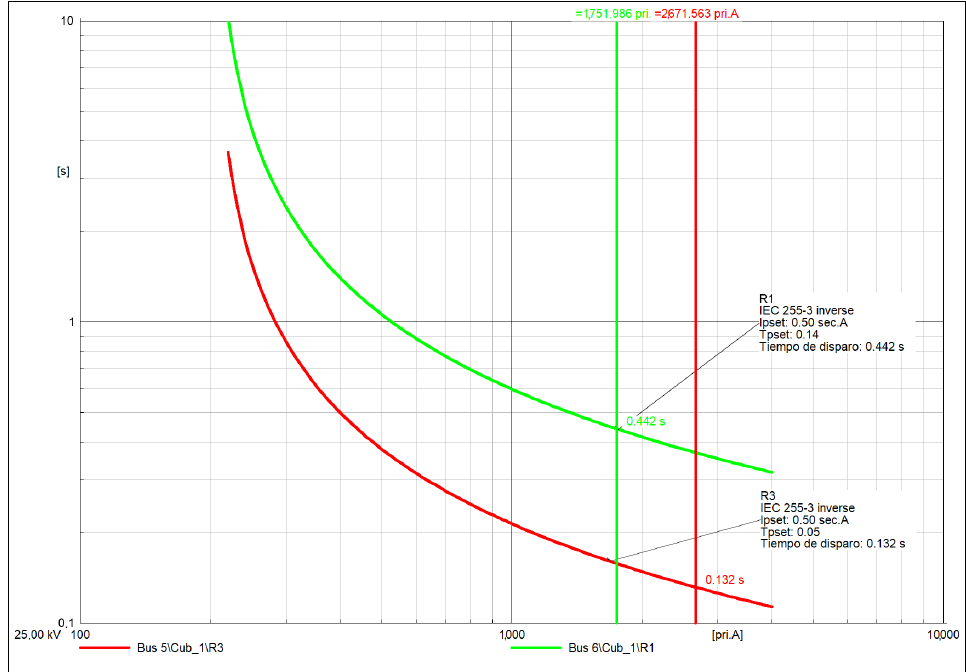
Figure 10. Coordination curve R1–R3 line fault DL-4 scenario EV1